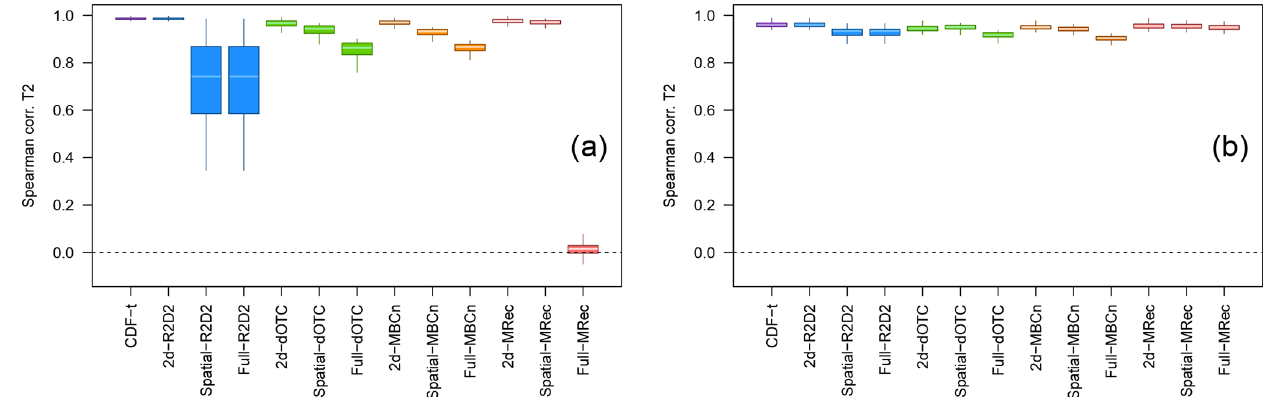
Figure 5. Boxplots of rank correlations computed at each grid cell between the bias-corrected and the raw climate model time series, for temperature, using (a) WFDEI for France and (b) SAFRAN for Brittany region during winter over the 1979–2016 period. Results are shown for CDF-t, R 2 D 2 , dOTC, MBC-n and MRec outputs for 2d-, Spatial- and Full- versions.